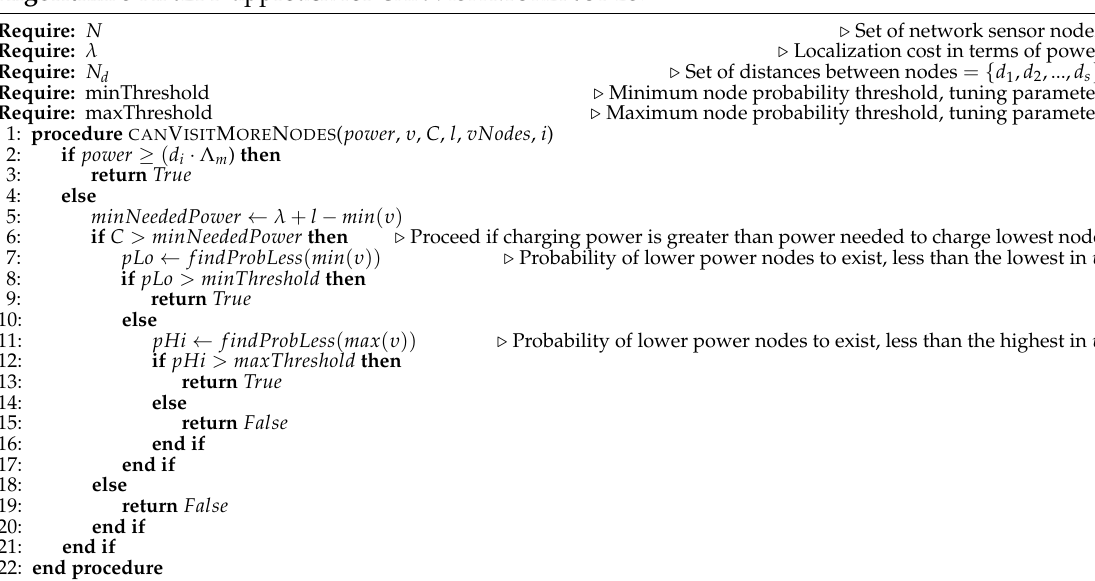
Algorithm 5 ANLPP approach for CAN V ISIT M ORE N ODES